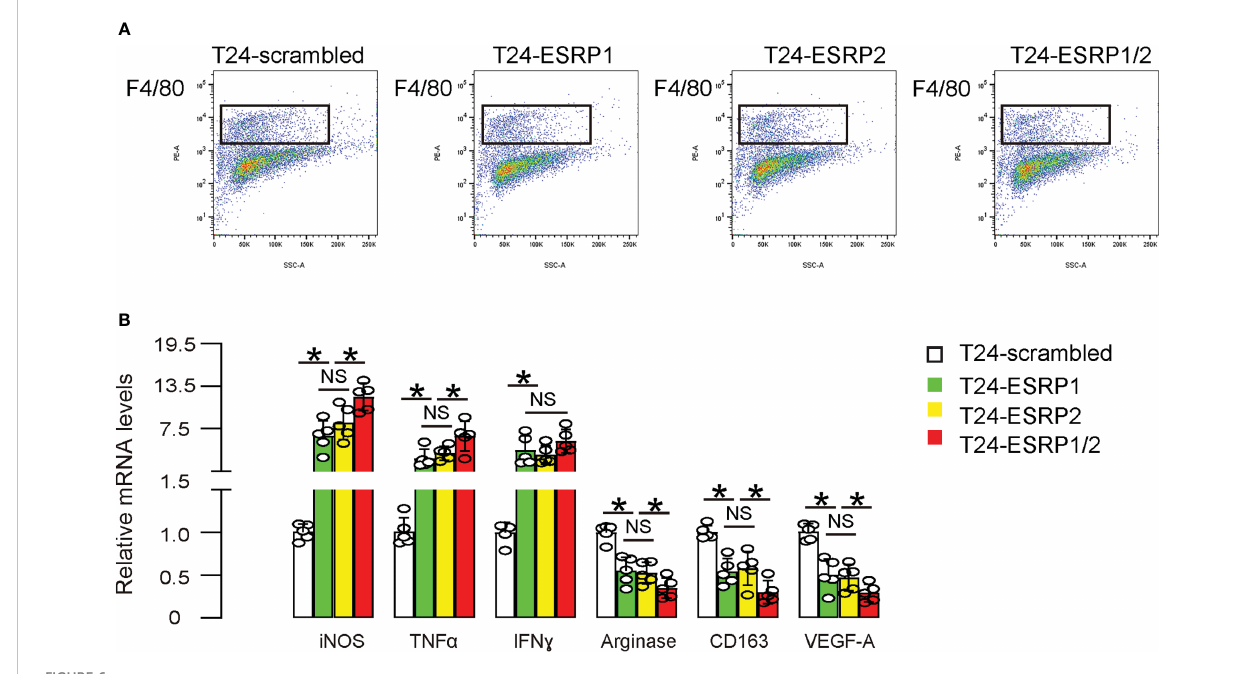
FIGURE 6 ESRP1/2 re-expression polarizes TAMs to an anti-tumor phenotype. (A) F4/80+ macrophages were isolated from the ESRPs-tumors by fl ow cytometry. (B) . RT-qPCR for proin fl ammatory macrophage-associated genes (iNOS, TNF a and IFN g ) and anti-in fl ammatory macrophage-associated genes (Arginase, CD163, VEGF-A) in puri fi ed macrophages from tumors. *p<0.05. NS, non-signi fi cant.